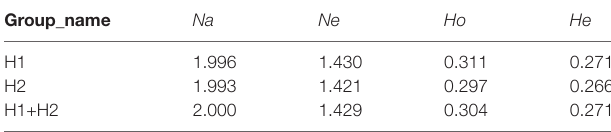
results ( Figure S5 ). The new results (Fst vs heterozygosity and dp3 vs . dp5) showed that the genetic differentiation is not driven by a few outlier loci and is affected by allele coverage depth, which is in close agreement with our conclusion